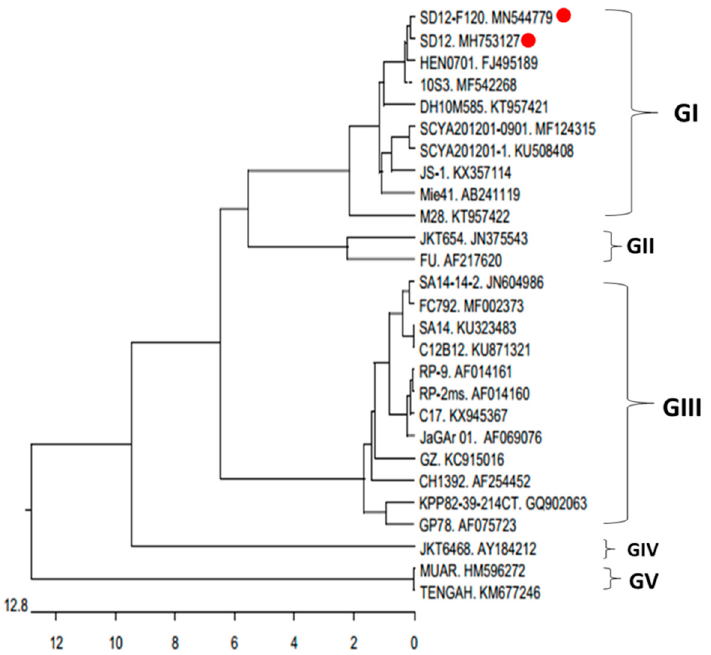
Figure 5. Phylogenetic tree of JEV strains based on the nucleotide sequence of JEV E gene. The phylogenetic tree was constructed by the neighbor-joining method using MEGA version 7.0 software. SD12-F120 and SD12 are labeled with red dot.